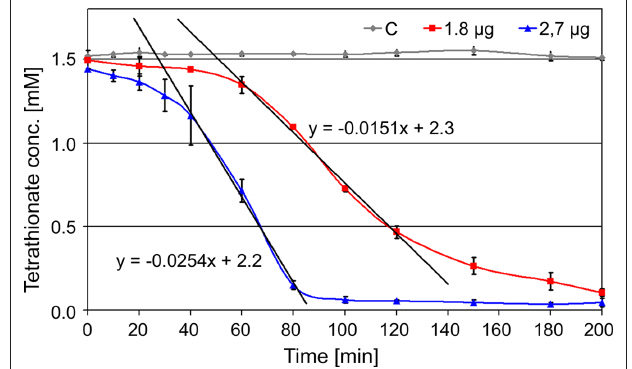
FiguRe 2 | Kinetics of TTH activity. 1.8 μg (red line) and 2.7 μg of protein (blue line) assayed at 80°C and pH 1; C: assay mixture without enzyme (control; gray line); formula, gradients of the trend lines used for activity calculation.